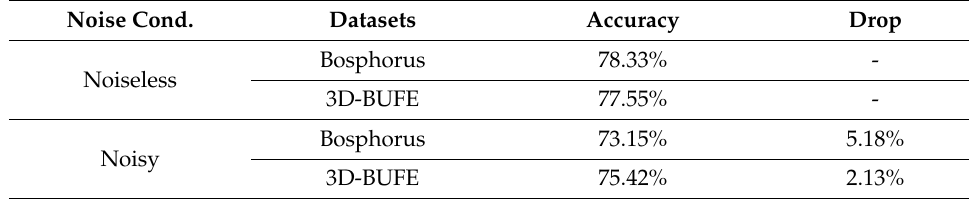
Table 7. Comparison of results with noiseless and noisy settings. Noise